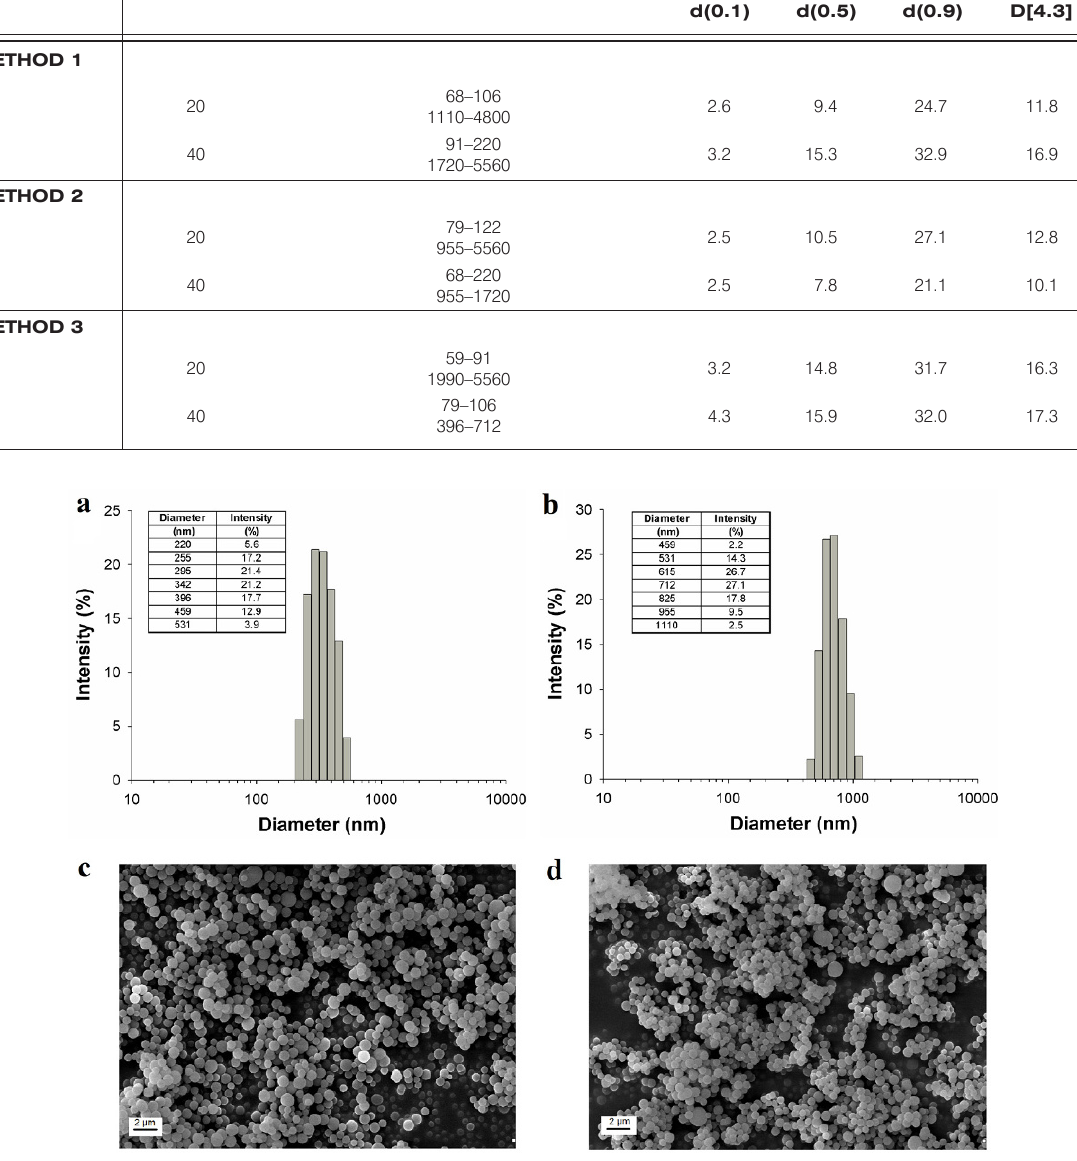
Figure 3. Particle size distributions measured on a Zetasizer Nano ZS and SEM images of (a, c) unmodified silica (sample 35) and (b, d) silica (sample 35) modified with aminosilane.